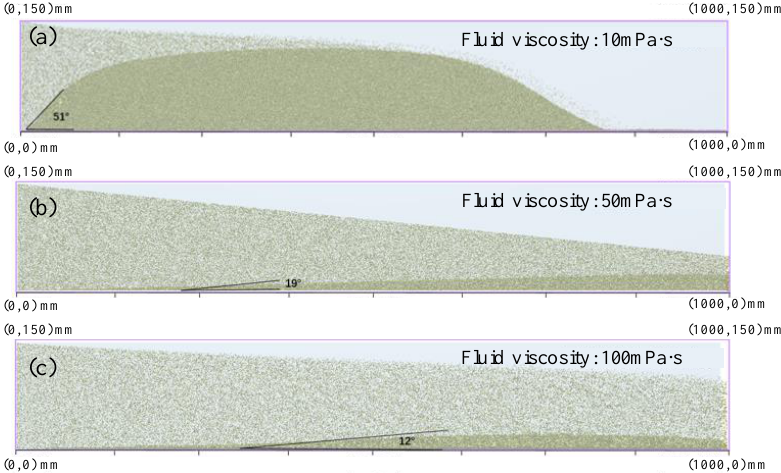
Figure 4. Proppant placement under different fracturing fluid viscosities: (a) 10, (b) 50, and (c) 100 mPa·s.